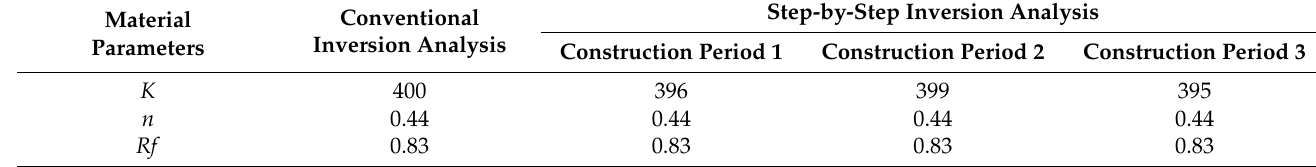
Table 3. Calculated material